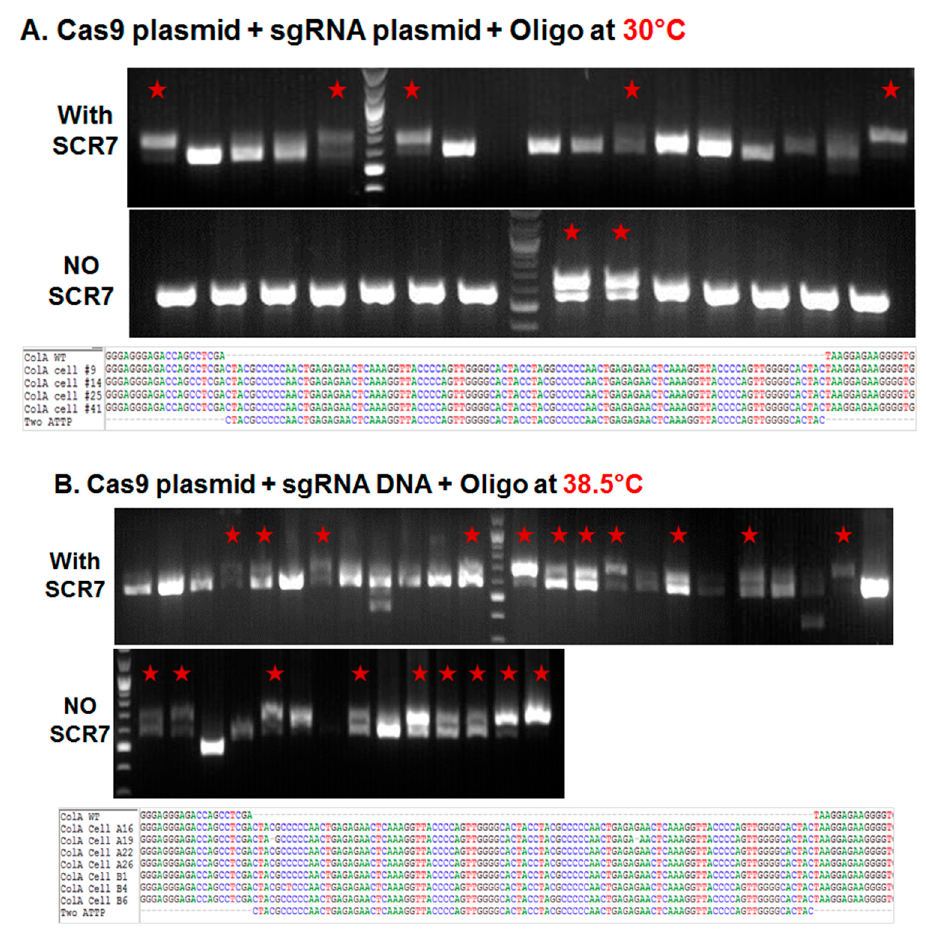
Figure 1. Cont. Figure 1.